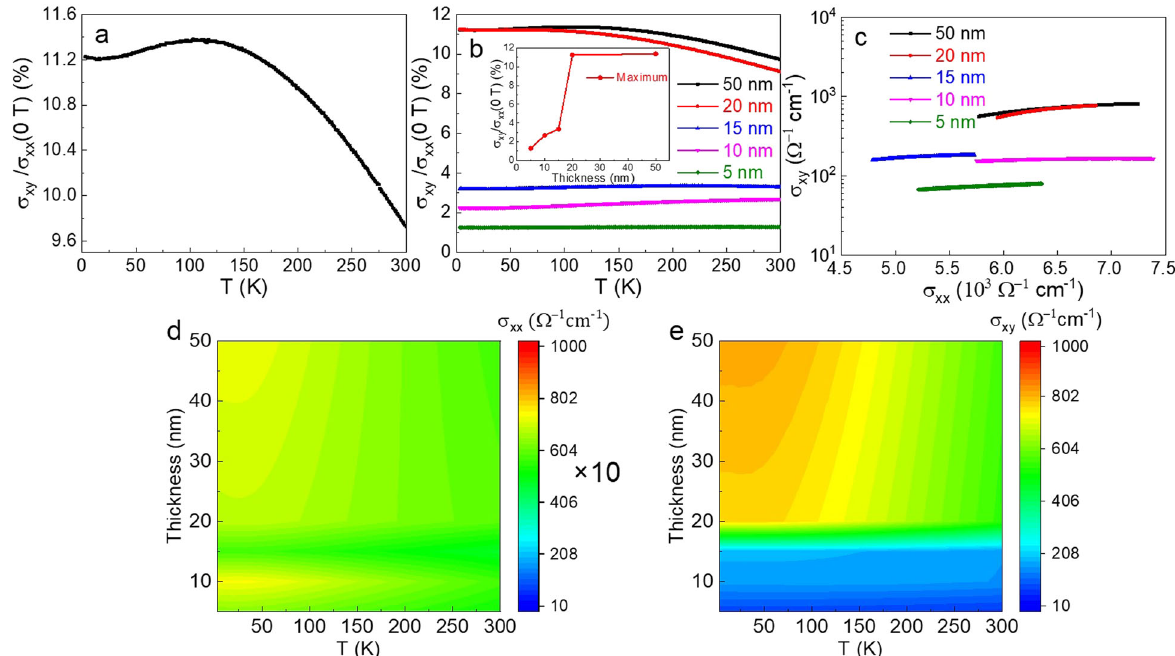
Fig. 3 Transport measurement of the anomalous Hall angle. a Temperature dependent anomalous Hall angle measured from 3 to 300 K for 50 nm Co 2 MnGa. b Thickness dependence of anomalous Hall angle as a function of temperature from 3 to 300 K, the inset is the maximum anomalous Hall angle as a function of thickness. c Log σ xy - σ xx plot for Co 2 MnGa with thicknesses from 5 to 50 nm. d , e Thickness dependence of σ xx and σ xy as a function of temperature from 3 to 300 K,